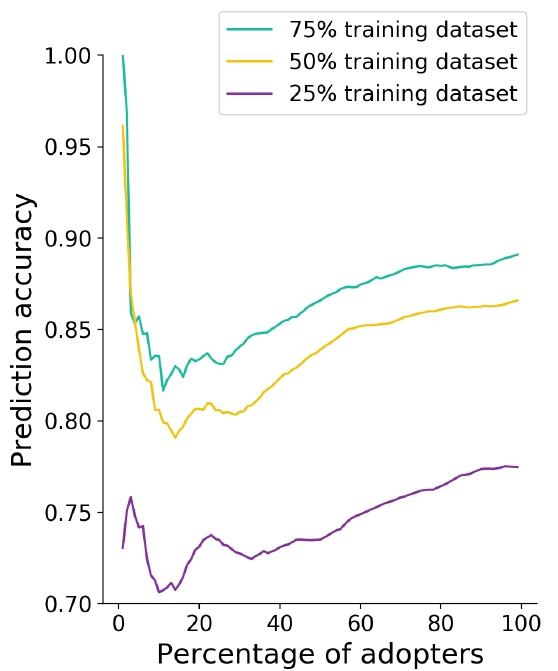
Figure 12. Accuracy of classification results with the use of Experience Factors for 25%, 50%, 75% training set and 10%, 20%, ..., 90% of adopters